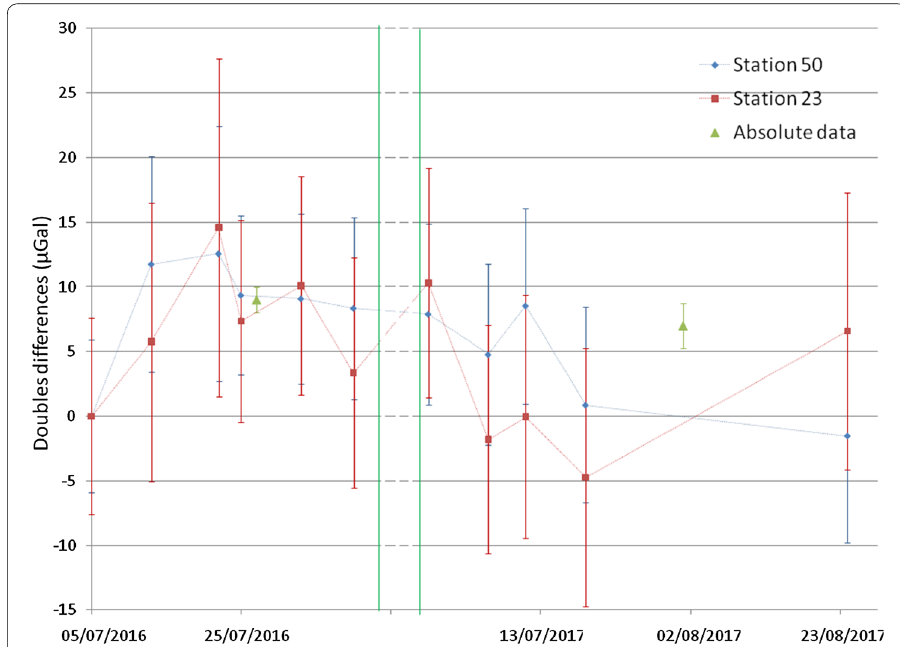
Fig. 8 Gravity double differences and their errors at the reference stations 23 and 50 compared to the obser‑ vatory of Strasbourg (STJ9) taking the 5th of July 2016 as temporal reference. Two absolute measurements are also displayed with their errors; absolute measurements are corrected for the effect of solid Earth and ocean loading tide, atmospheric pressure, polar